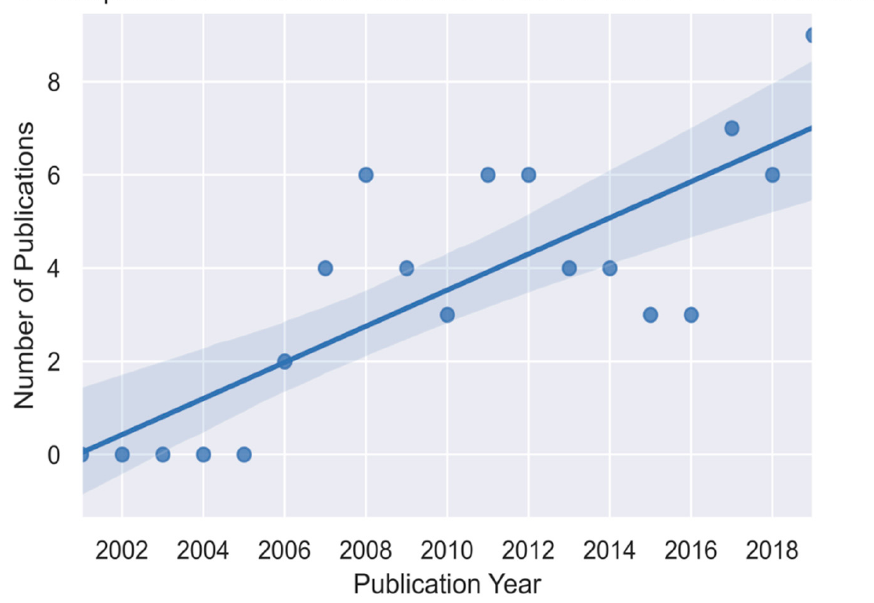
Figure 3. Scatter plot showing the correlation between years and number of publications.